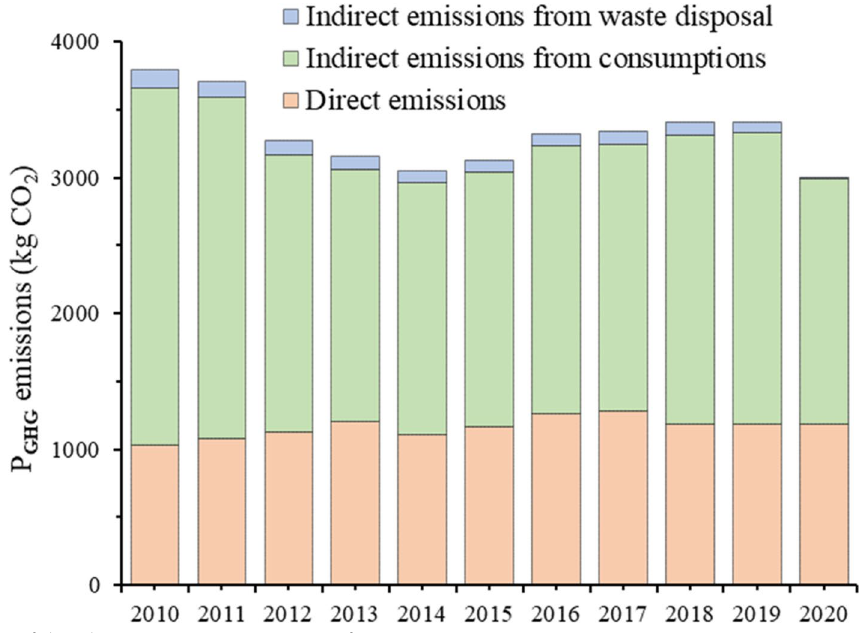
Fig. 2 The variations of Shanghainese average P GHG emissions from 2010 to 2020